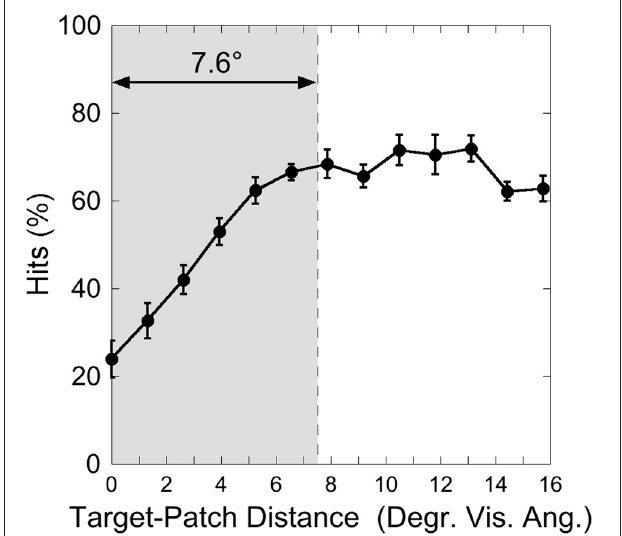
FIGURE 7 | Experiment 2: hits as a function of target-patch distance, averaged over the conditions “Red Patch” and “Green Patch.” The gray field represents the critical distance (averaged over participants). Black bars depict standard errors.